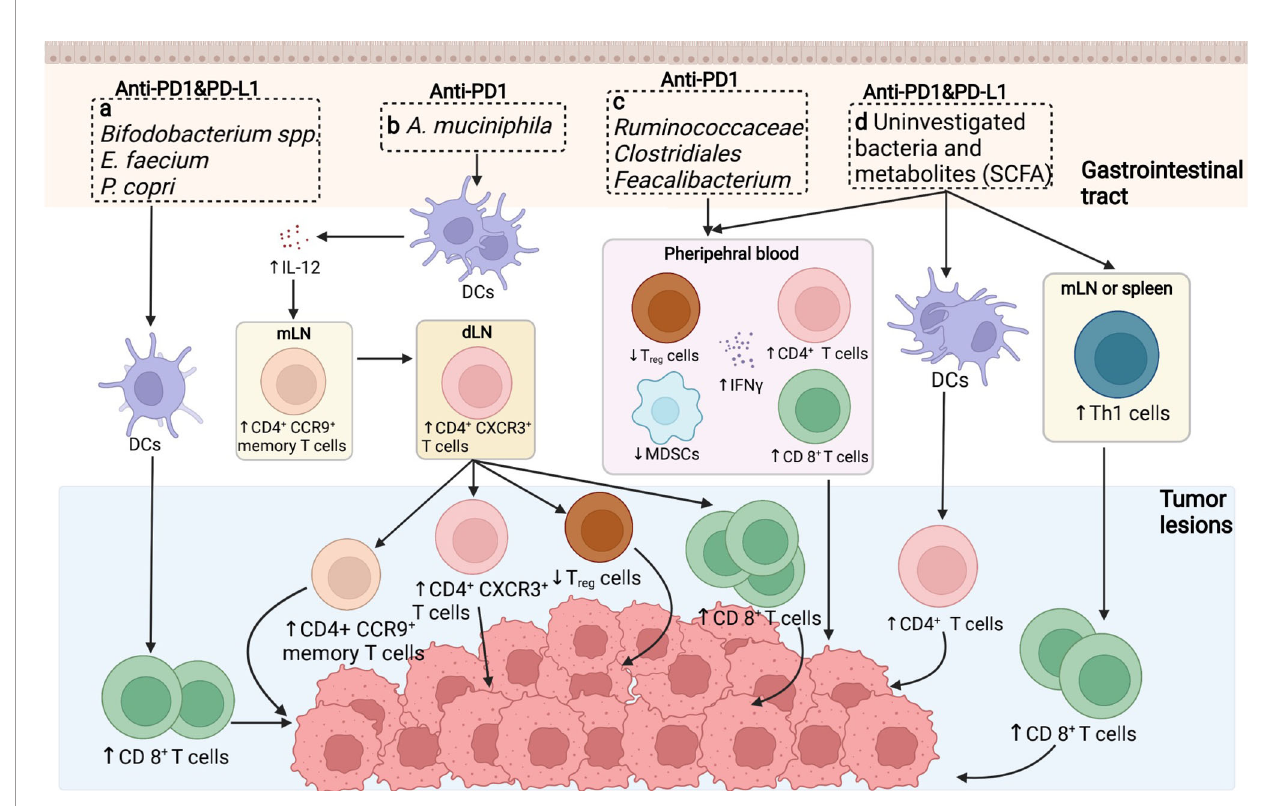
FIGURE 1 | Putative mechanisms concerning the role of the gut microbiome in anti-PD1/PD-L1 immunotherapy. (A) In preclinical murine models, the abundance of Bi fi dobacterium spp./ Enterococcus faecium etc. was shown to increase the cytotoxic T cell function in cancerous sites to facilitate tumor killing. (B) The enrichment of Akkermansiacea muciniphila in anti-PD-L1 responders is correlated with enhanced dendritic cells (DCs) activation, thus provoking IL-12 secretion, promoting the traf fi cking of CD4 + CCR9 + memory T cell and CD4 + CXCR3 + T cells from mesentery lymph nodes (mLNs) to tumor draining lymph nodes (dLNs), ultimately enhancing anti-tumor effect by motivating effector T cells. (C) Ruminococcaceae/Clostridales/Feacalibacterium in the GI tract mediate in anti-tumor effect via enhancing the ratio of CD4 + and CD8 + T cell ratio while downregulating the activity of regulatory T cells and myeloid derived suppressor cells (MDSCs). (D) Bacteria themselves and associated metabolites are also potential regulators in anti-PD1/PD-L1 therapy, primarily via driving Th1 cell differentiation peripherally, potentiating DCs function as well as diminishing circulating regulatory T cells (T regs ), thus ameliorating immunosuppression and reinforcing immune